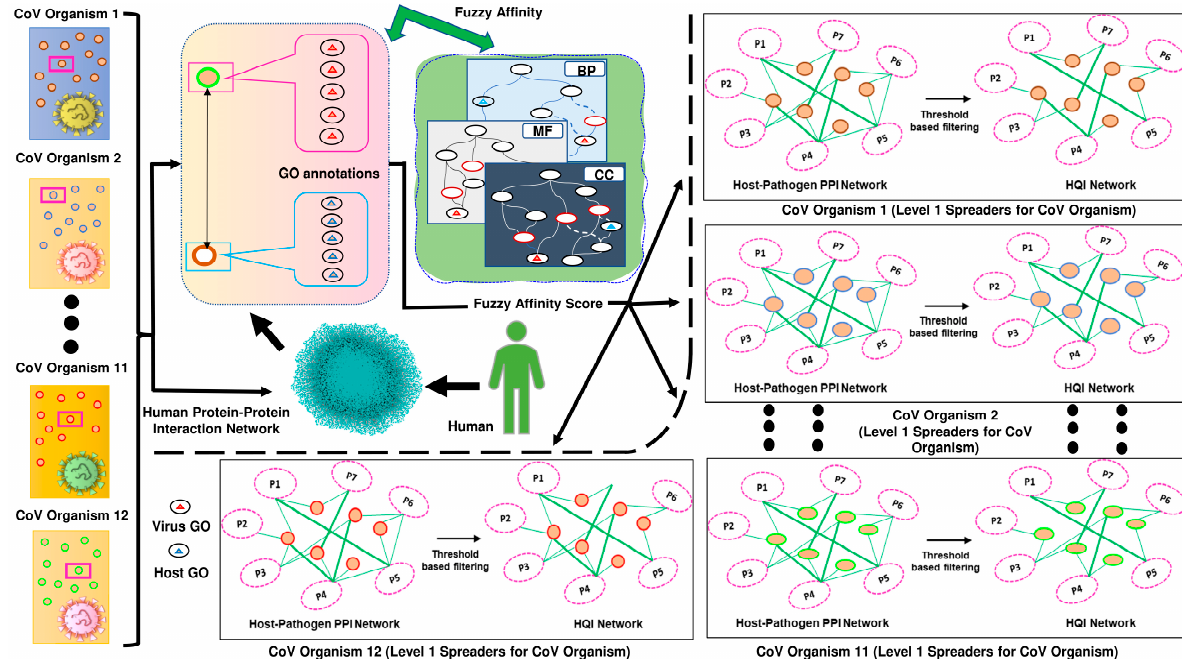
Figure 1. Schematic diagram of our proposed model. The coronavirus and human proteins’ inter- action affinities are determined by the model using gene ontology information of the proteins. Three different GO-relationship graphs, CC, MF, and BP, are used to evaluate all GO pair-wise interaction affinities. A protein pair’s fuzzy interaction affinity is calculated using the three pair-wise scores of all GO-pair affinities.